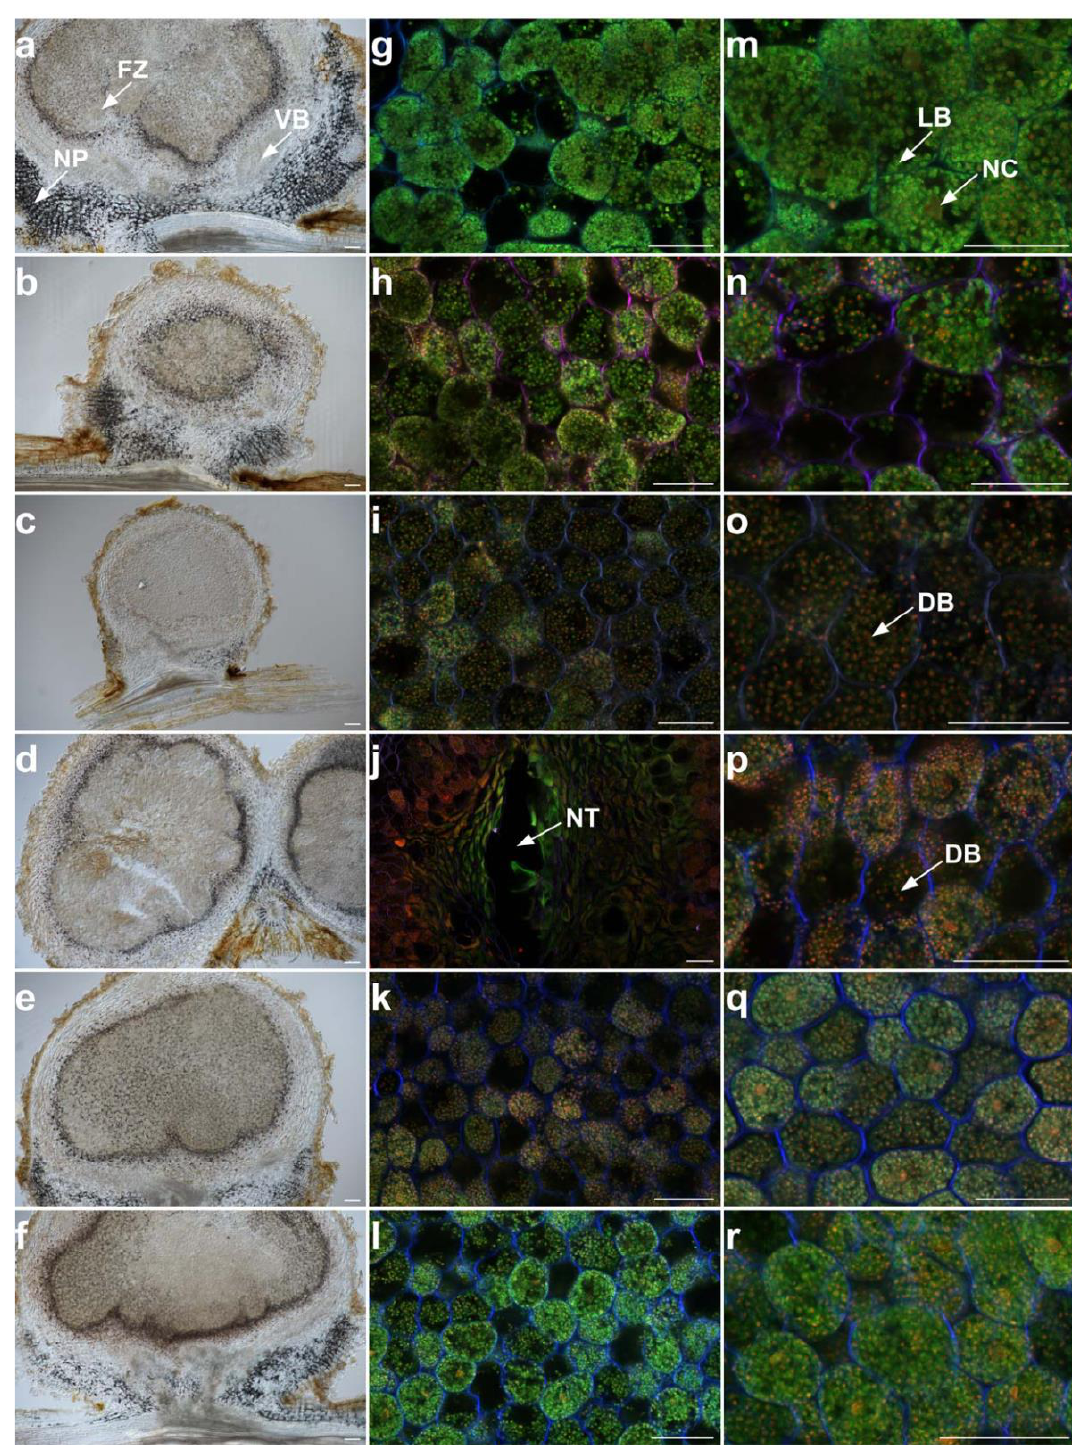
Figure 5. Longitudinal sections of the nodules of 5 CSSLs and the recurrent parent Fleur11 35 days after inoculation with B. vignae ISRA400. Differential interference contrast microscopic images ( a – f ) showing nodule structure and confocal microscopic images ( g – r ) showing live (green) bacteria, dead (red) bacteria, and plant cell walls (blue). Nodule sections of Fleur11 ( a , g , m ); line 12CS_004 ( b , h , n ); line 12CS_044 ( c , i , o ); line 12CS_051 ( d , j , p ); line 12CS_084 ( e , k , q ); and line 12CS_114 ( f , l , r ). FZ: fixation zone; NP: nodule parenchyma or inner cortex; VB: vascular bundles; NC: nucleus; NT: collapsed necrotic tissue; LB: live bacteroids; DB: dead bacteroids. Scale bar = 50 µ